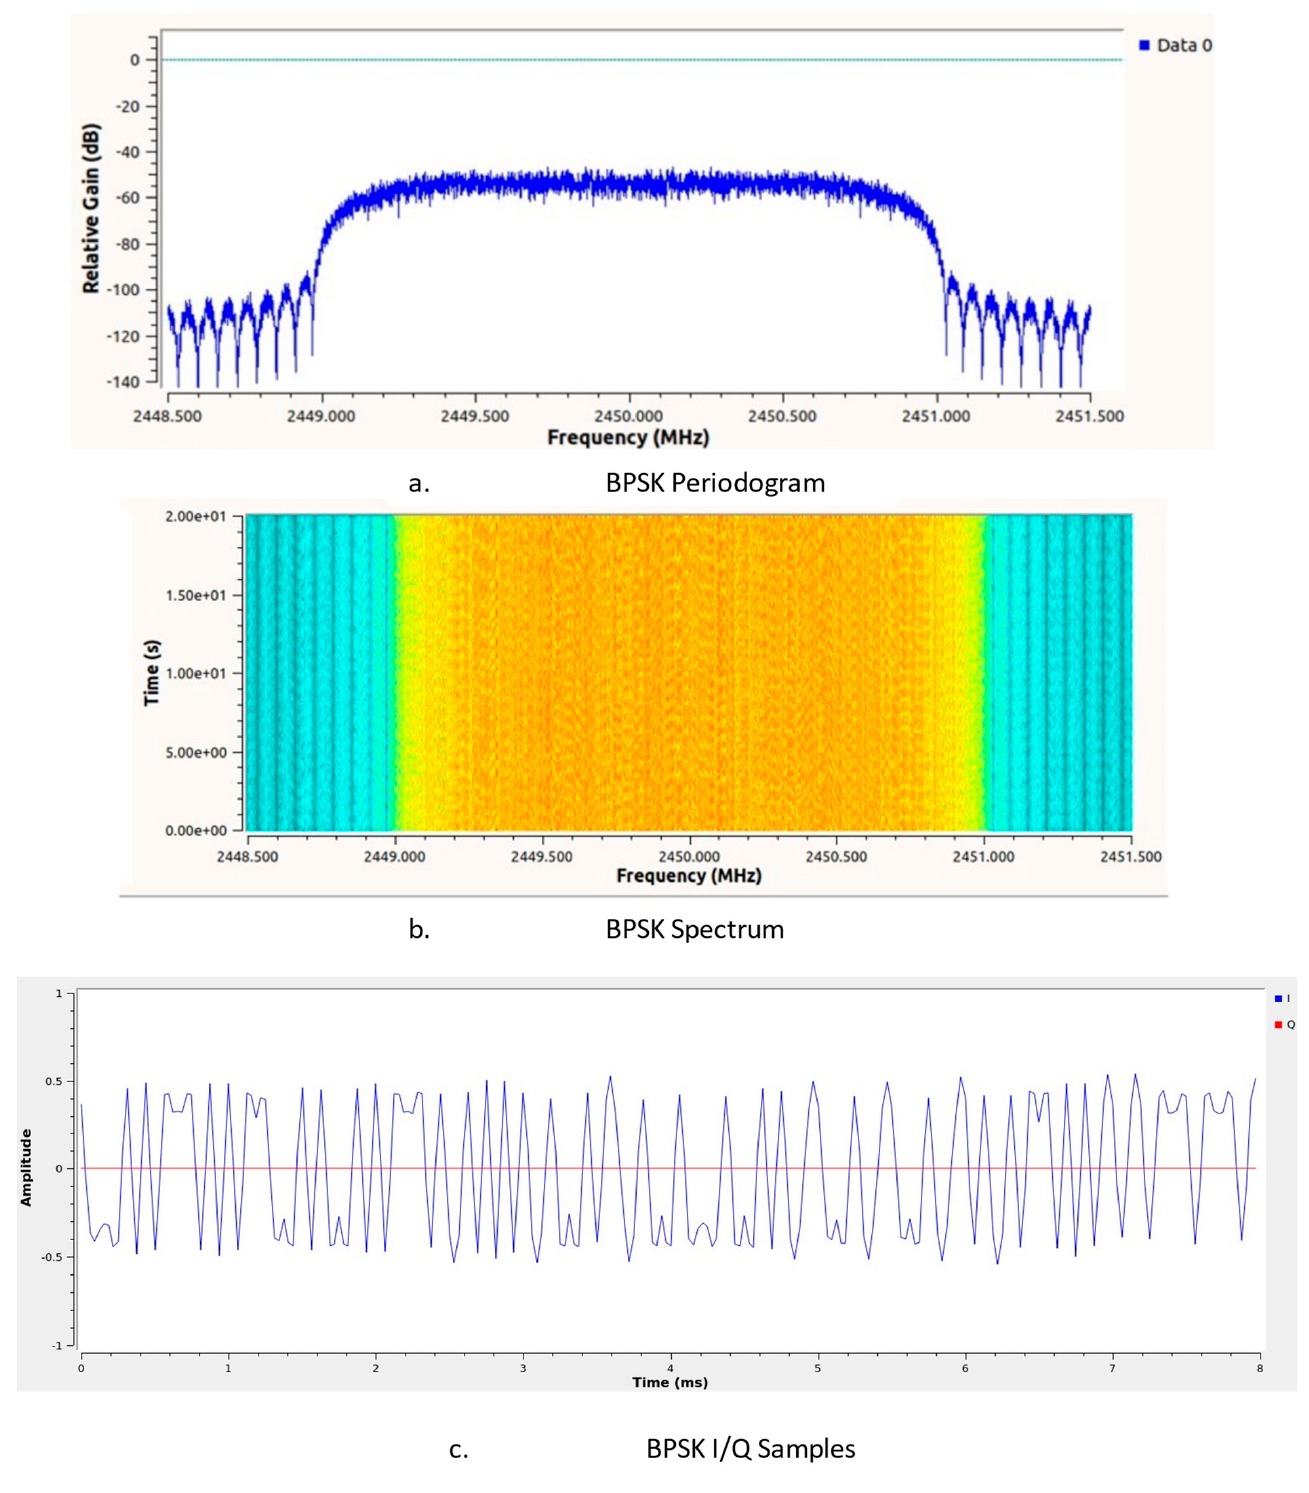
Figure 5. BPSK Modulated Signal. ( a ) BPSK Periodogram; ( b ) BPSK Spectrum; ( c ) BPSK I/Q Sam ‐ ples.